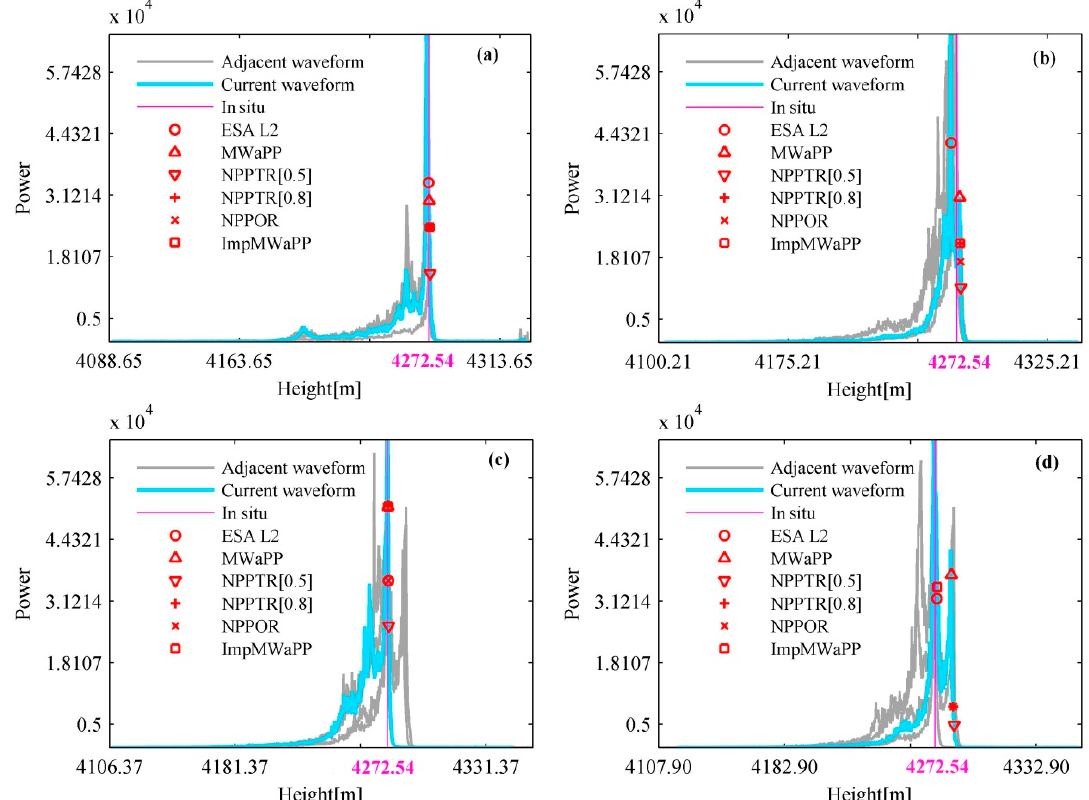
Figure 7. Retracked results for four waveforms corresponding to spots ( a ) 1, ( b ) 5, ( c ) 8, and ( d ) 9 in Figure 3a. Magenta numbers represent the values of the in situ water levels.